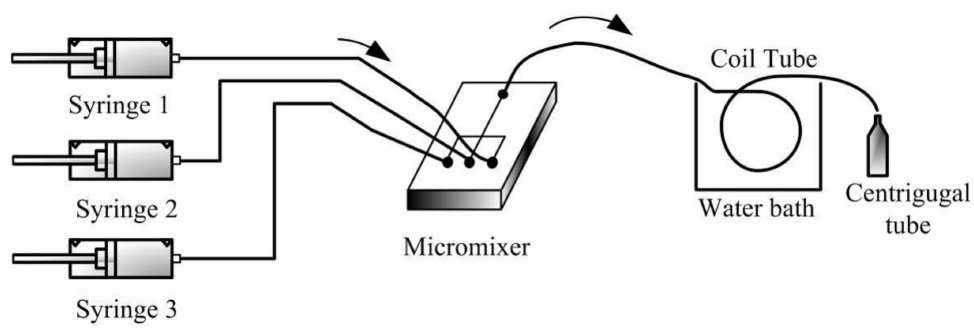
Figure 23. Continuous-flow system with a planar micromixer and coil aging tube.